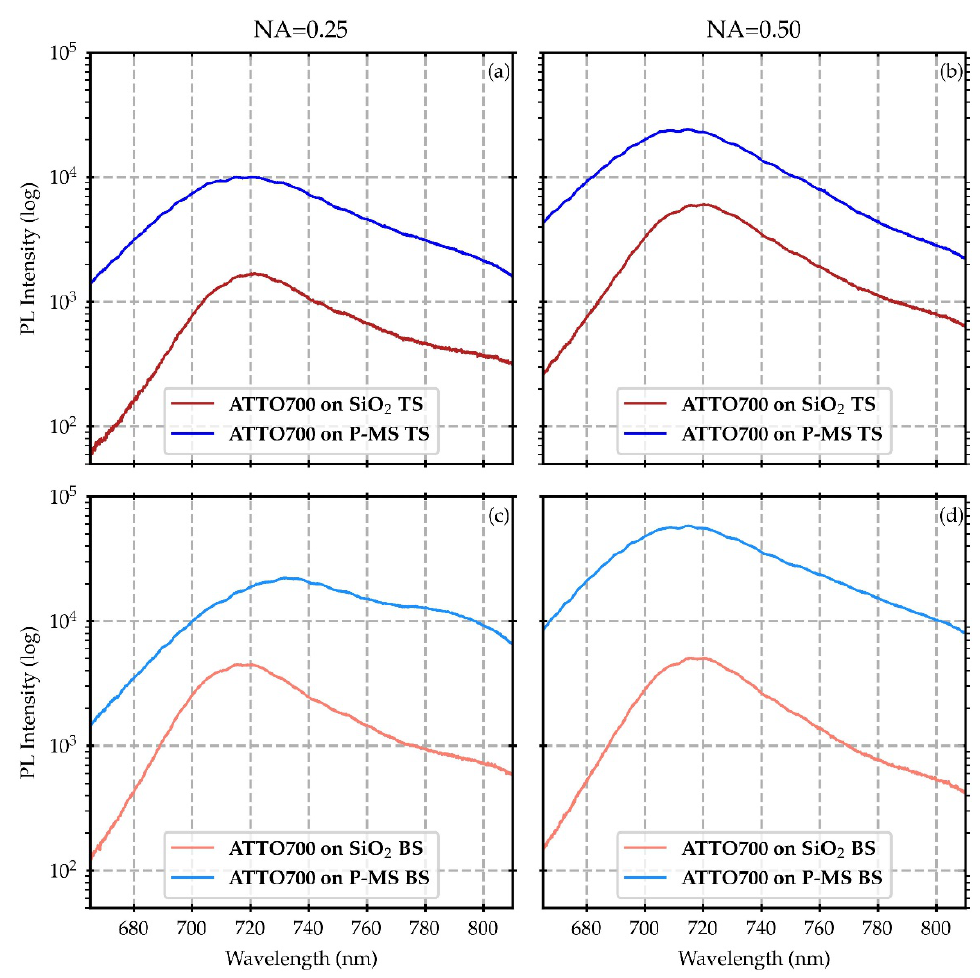
Figure A2. Photoluminescence spectra of ATTO700 dye deposited on the top side of the plasmonic metasurface (P-MS) and on the SiO 2 reference slide. First row refers to the excitation and collection from the FS for microscope objective numerical apertures of NA = 0.25 ( a ) and NA = 0.50 ( b ). Panels ( c , d ) refer to the excitation and collection from the BS for microscope objective numerical apertures of NA = 0.25 and NA = 0.50, respectively.